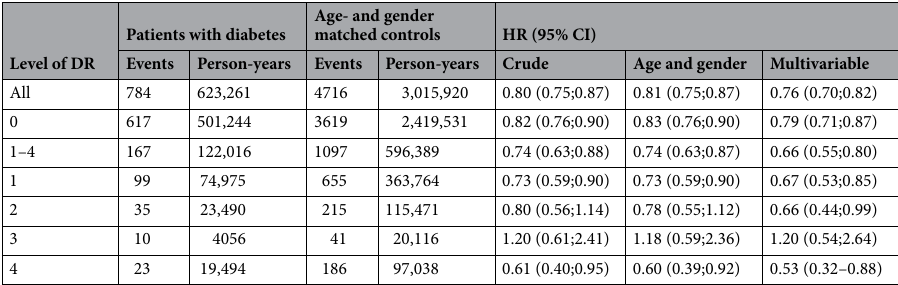
Table 3. Incident migraine in patients with diabetes according to level of diabetic retinopathy and their corresponding age- and gender-matched controls. Hazard ratio (HR) with 95% confidence interval (CI) for 5-year incident migraine after index date for patients with diabetes mellitus screened for diabetic retinopathy (DR) and age- and gender-matched controls according to level of DR for cases. CI confidence interval. Level of DR given by the worse eye. Multivariable model adjusted adjusted for sex, age, marital status, use of lipid lowering drugs and Charlson comorbidity index: myocardial infarct, congestive heart failure, cerebrovascular disease, chronic pulmonary disease, connective tissue disease/rheumatologic disease, ulcer disease, mild liver disease, hemiplegia/hemiplegia or paraplegia, any malignancy (including leukemia and lymphoma), moderate- severe liver disease, solid metastatic tumor, and acquired immunodeficiency syndrome.